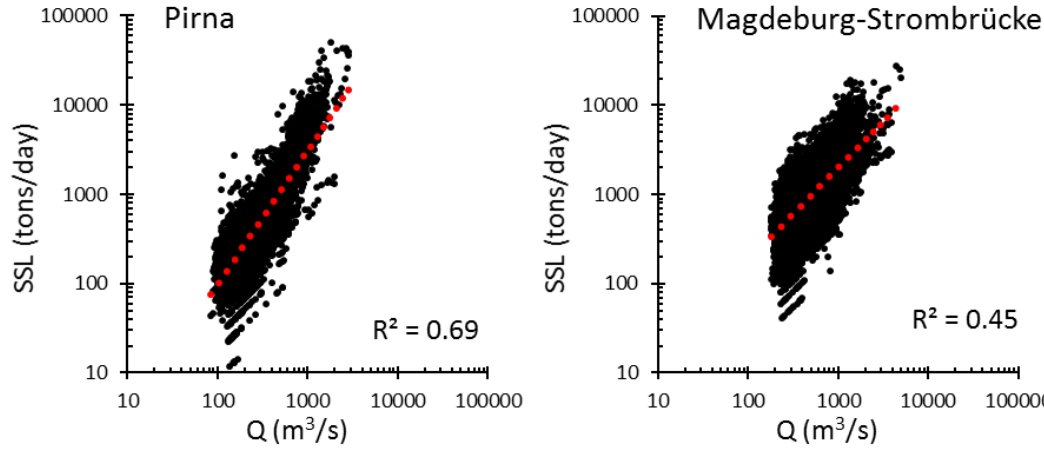
Figure 6. Applied SRCs for the stations.